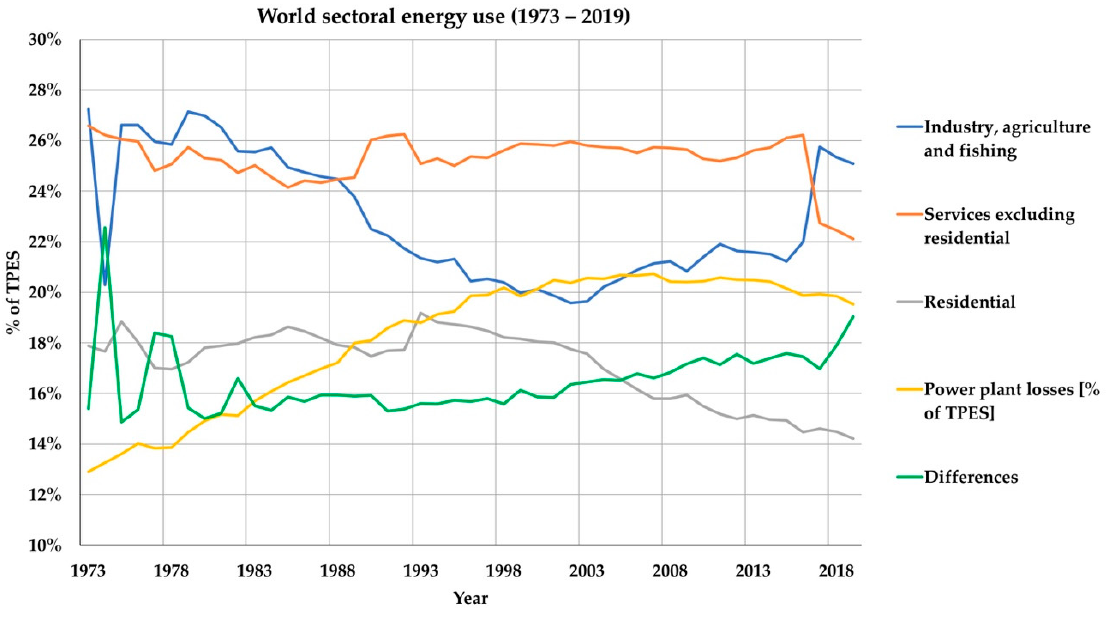
Figure 7. World sectoral final consumption, power losses and remaining differences (i.e., energy own ‐ use, exports, non ‐ energy use and stocks) interpreted according to Figure 6. Data include the years from 1973 to 2019. Data, expressed as percentage of input (i.e., Total Primary Energy Supply), are provided from official IEA statistics .